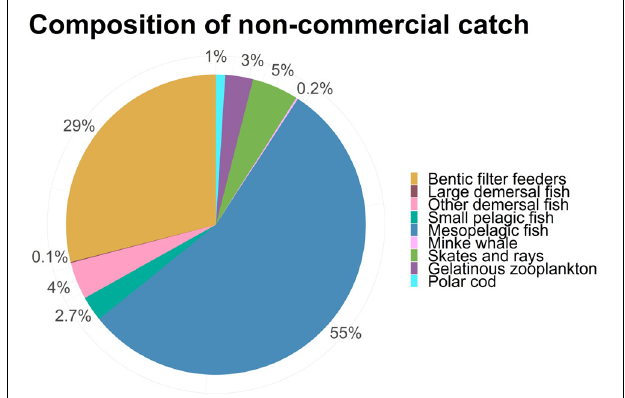
FIGURE 8 | The composition of the total catch of non-commercial species (Excluding